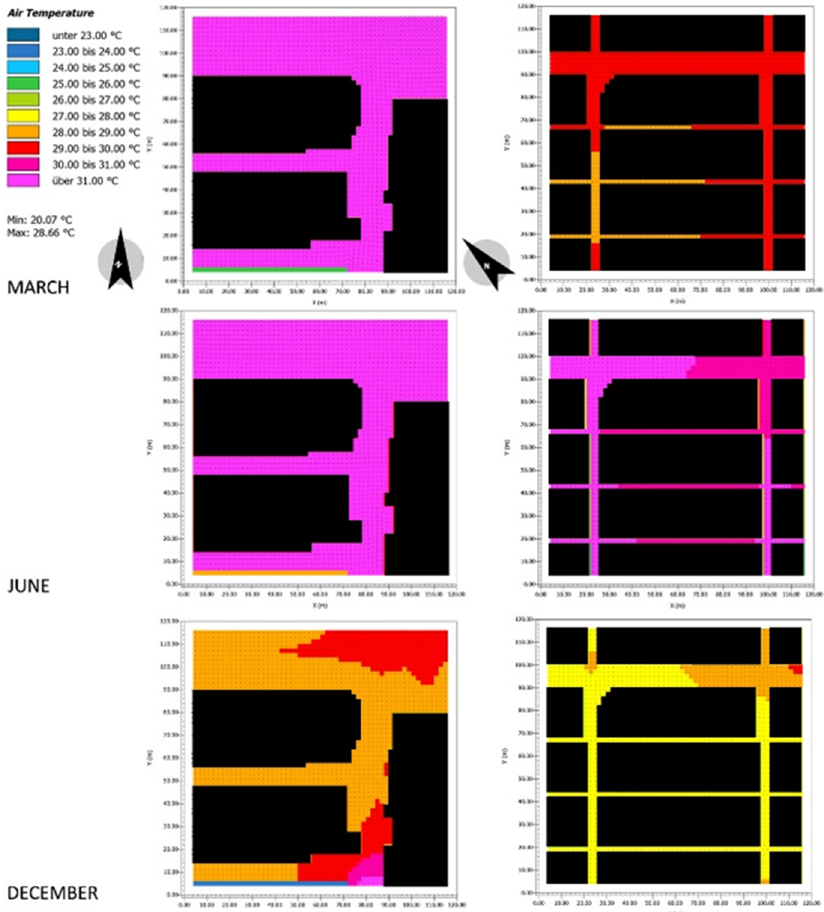
Figure 15. Distribution of air temperature of the two studied urban pattern types.